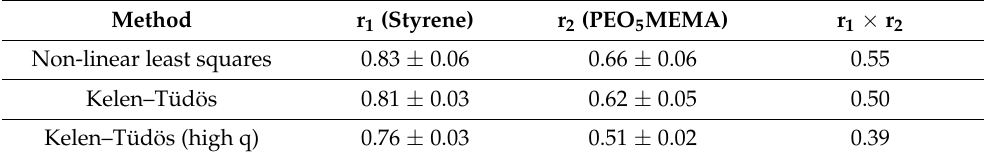
Table 1. Reactivity ratios for the copolymerization of styrene/PEO 5 MEMA using the non-linear least squares method, Kelen–Tüdös and Kelen–Tüdös at high monomers conversion linearization